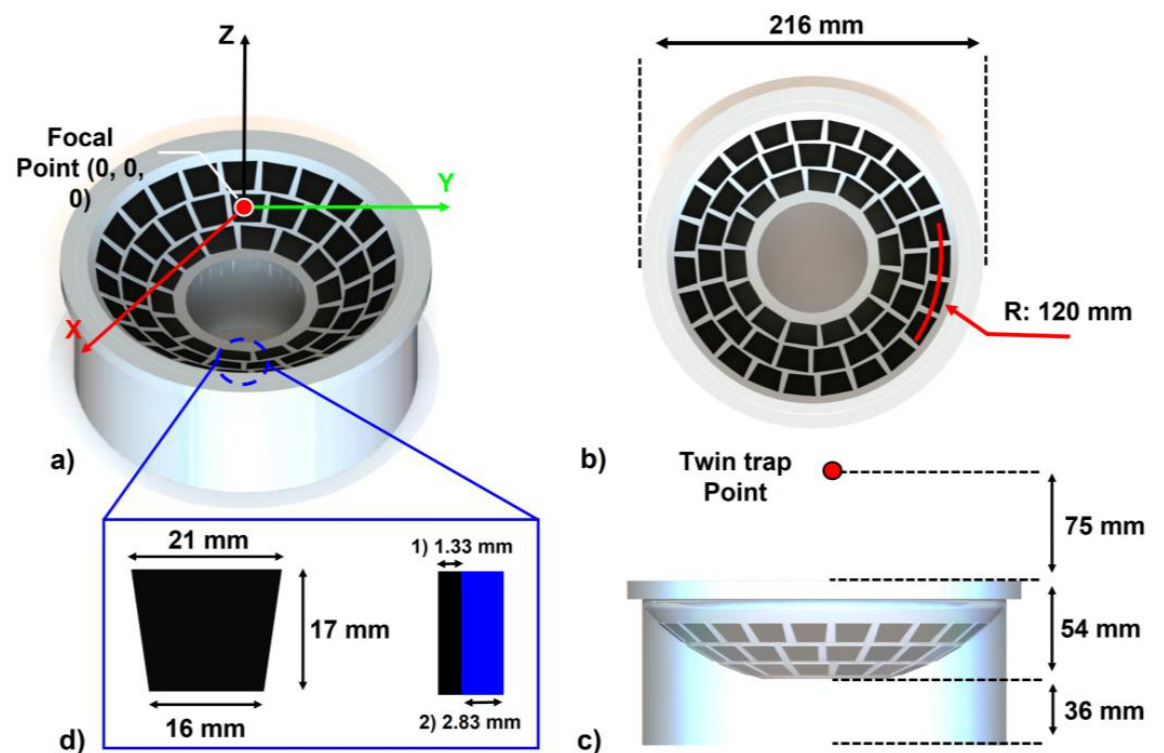
Figure 2. Single-side UTs array geometry design: ( a ) isometric view; ( b ) top view; ( c ) lateral view; and ( d ) size of the single element and thickness of matching layer and PZT layer. Table 1. Specification of the 56-channel model.